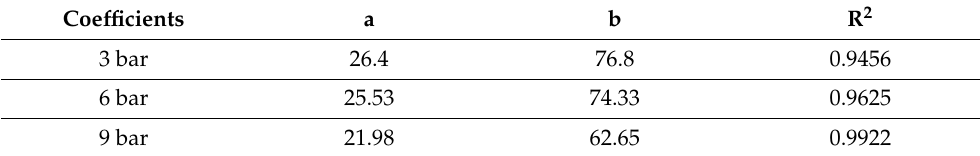
Table 1. Model coefficients.